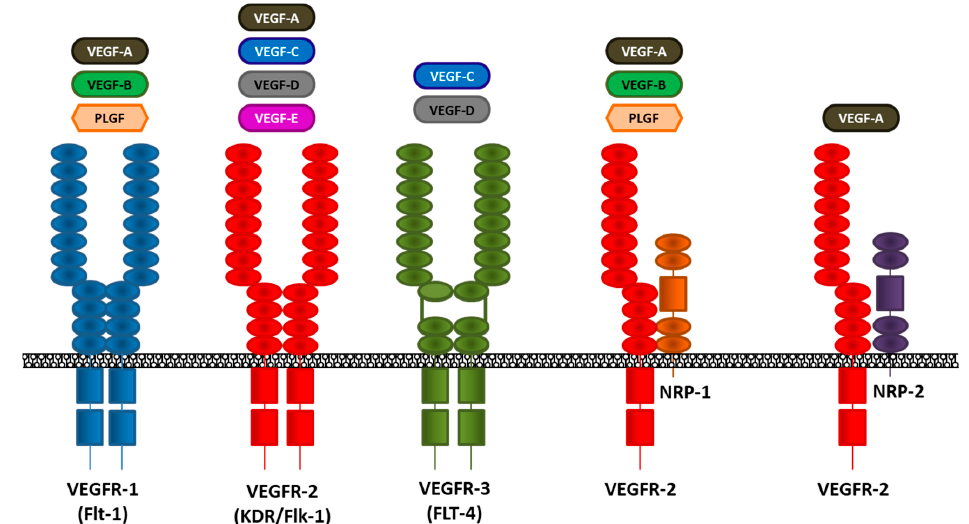
Figure 1. Schematic representation of VEGFRs and relative ligands. VEGFR-1 is expressed in a subset of hematopoietic bone marrow progenitor cells, monocytes/macrophages, smooth muscle cells, and several cancer cells. VEGFR-2 is expressed prevalently in vascular endothelial cells and progenitors, neurons, and megakaryocytes, but it can be expressed on the surface of several cancer cells. VEGFR-3 is restricted to lymphatic endothelial cells. Neuropilins are expressed prevalently by cells of the nervous system, and they work as co-receptors in the endothelial cell during the angiogenic process. VEGF: vascular endothelial growth factor; VEGFR: VEGF receptor; PLGF: placental growth factor; Flt-1: Fms-like tyrosine kinase-1; KDR: Kinase insert domain receptor; Flk-1: Fetal Liver Kinase-1; FLT-4: Fms-like tyrosine kinase-4; NRP: neuropilin. Ferrara and Henzel first purified VEGF, a glycoprotein with mitogenic activity for vascular ECs, from bovine pituitary folliculo-stellate cells [62,63]. The VEGF family is composed of six members: VEGF-A, -B, -C, -D, -E, and placental growth factor (PlGF) that recognize and specifically bind three different transmembrane receptor tyrosine kinases, which are VEGFR-1, -2 and -3 (Figure 1). The